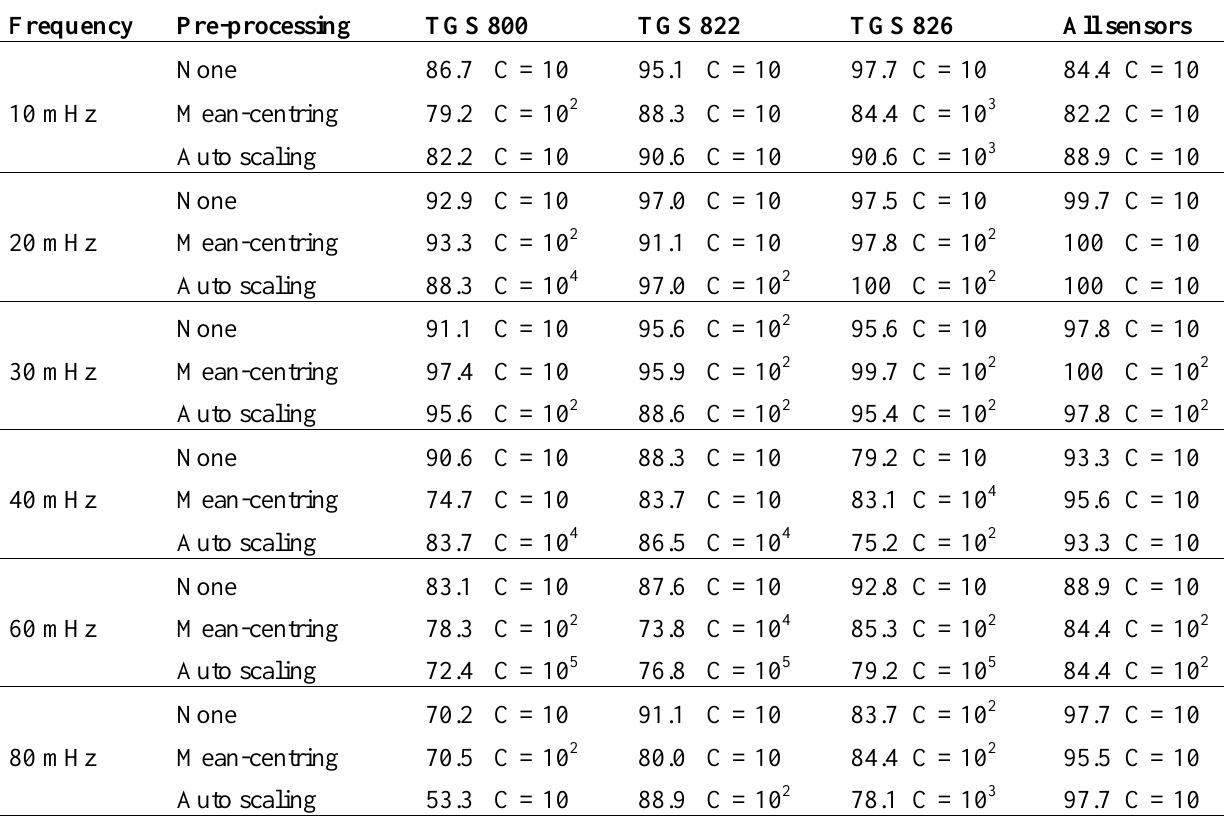
Table 3 . Success rate in vapour identification (%) using flow modulation. Validation results are reported. The optimal value of parameter C is also